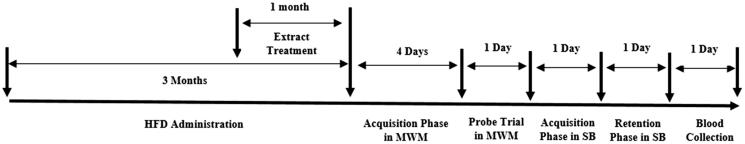
Timeline of experiments.